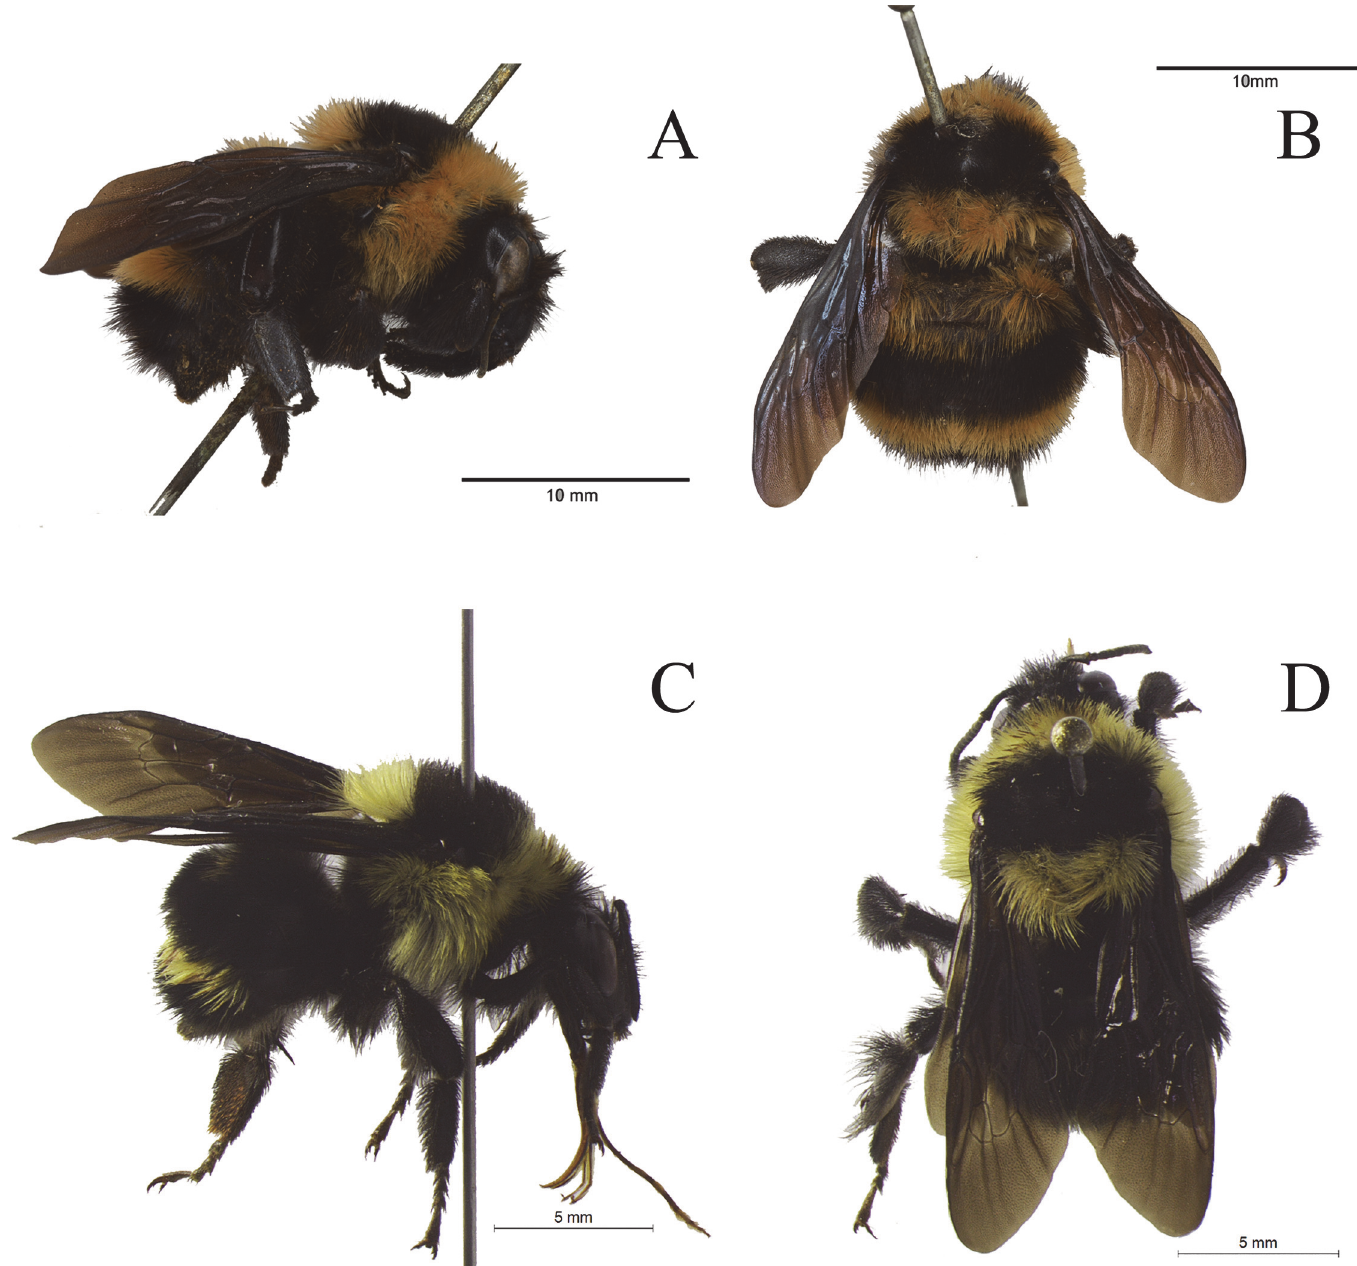
Fig 1. Types of Bombus brasiliensis Lepeletier, 1836 and Bombus bahiensis sp. n. Lectotype of B . brasiliensis — A: lateral view of head, mesosoma and metasoma; B: dorsal view of mesosoma and metasoma. Holotype of B . bahiensis sp. n. — C: lateral view of head, mesosoma and metasoma; D: dorsal view of mesosoma and